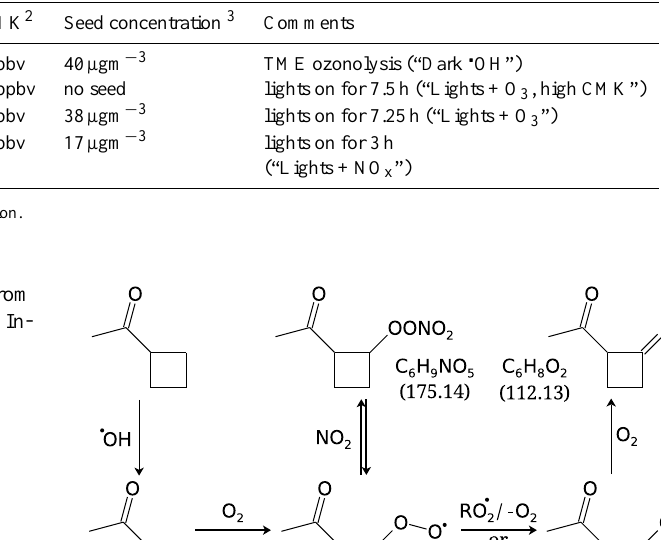
Table 1. List of performed cyclobutyl methyl ketone (CMK) oxidation experiments.